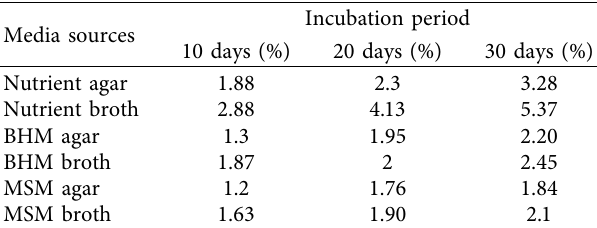
Table 3: Weight reduction percentage of PP mask pieces after 30- day treatment with Pseudomonas sp. on different media